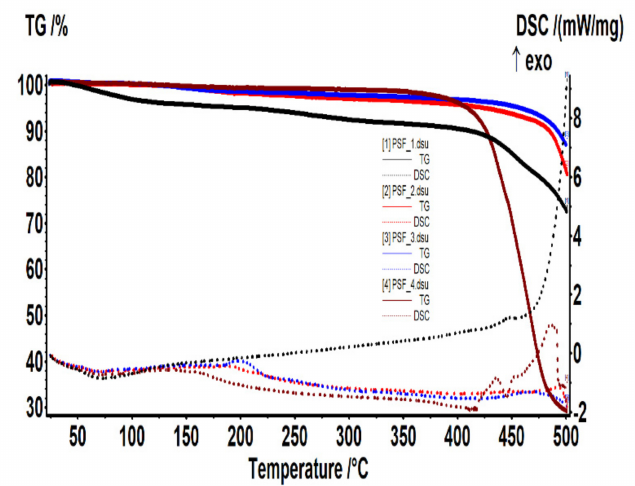
Figure 8. The set of thermal analysis data for the four